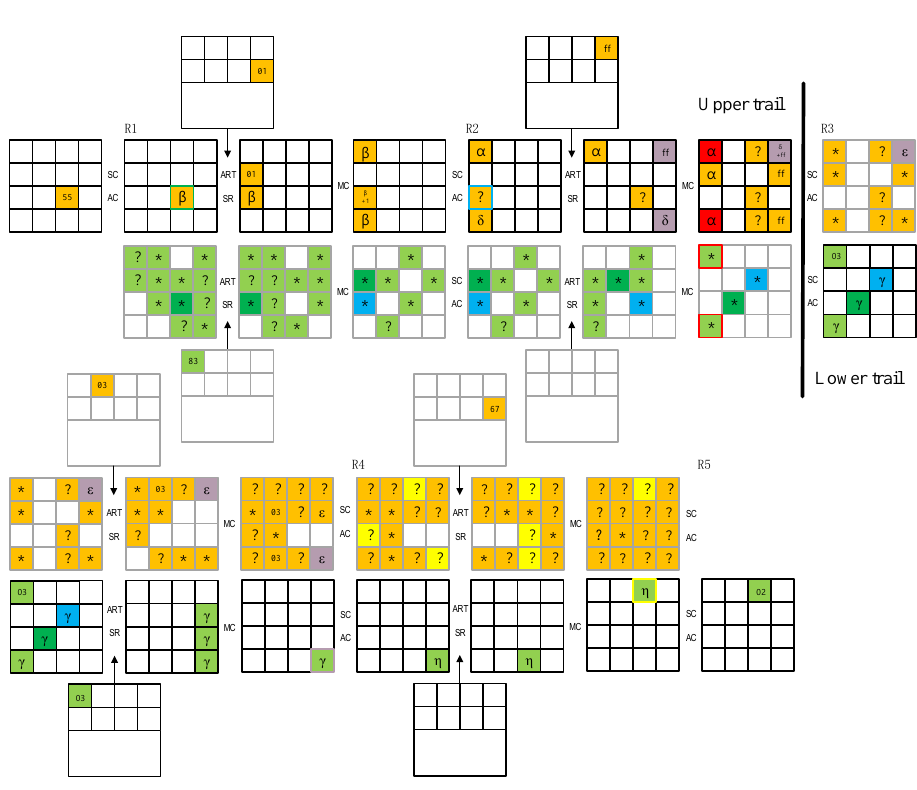
Figure 4: The five middle rounds of the 18-round boomerang distinguisher of SKINNY -128-256